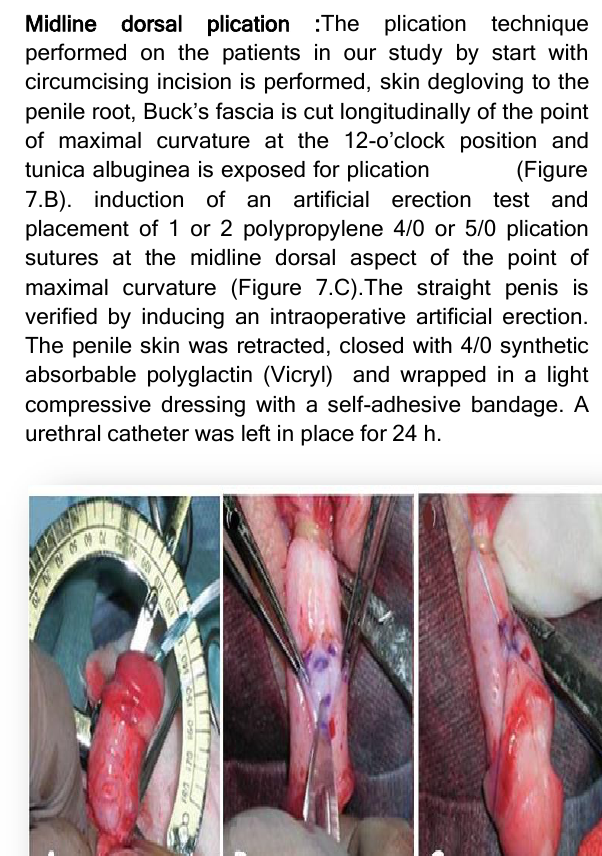
buries the knots.